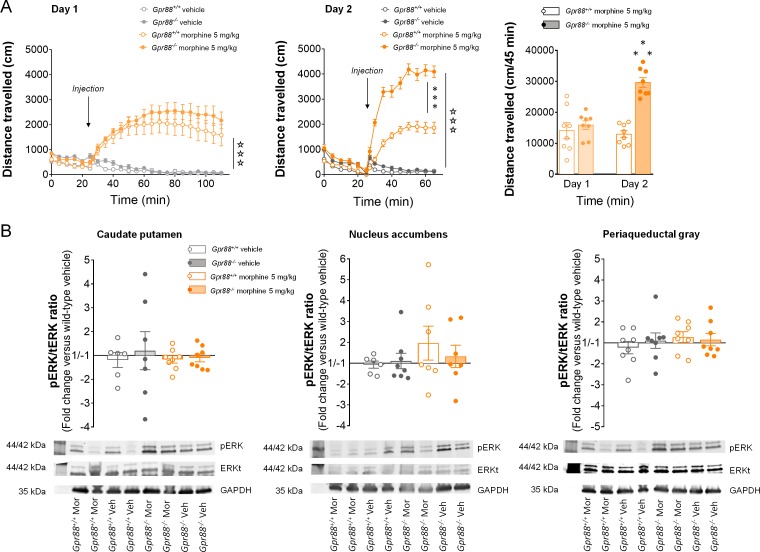
Increased morphine-induced locomotor sensitization in Gpr88 null mice was not associated with modified pERK/tERK ratio in three brain regions.(A) In a two-day locomotor sensitization paradigm (n = 8 mice per treatment and genotype), morphine (5 mg/kg) induced an increase in locomotor activity (Day 1; Genotype: F1,28=0.83, p=0.3690; Treatment: F1,28=63.4, p=0.0000; Time: F17,176=11.1, p=0.0000) that sensitized after a second administration (Day 2) in Gpr88-/- but not Gpr88+/+ mice (right panel; Genotype: F1,28=78.2, p=0.0000; Treatment: F1,28=365.5, p=0.0000; Genotype x Treatment: F1,28=58.9, p=0.0000; Time: F8,224=76.8, p=0.0000; Time x Genotype: F8,224=7.0, p=0.0000; Time x Treatment: F8,224=139.9, p=0.0000; Time x Genotype x Treatment: F8,224=13.13, p=0.0000). Data are presented as mean ± SEM. Open stars: Time x Treatment interaction, asterisks: Genotype x Treatment (three-way ANOVA with one repeated measure – time bin), three symbols: p<0.001. (B) The mice were sacrificed 60 min after the second morphine challenge for western blot analysis. Upper panels: in contrast with in vitro results, no difference was observed in the pERK/tERK ratio between Gpr88-/- and Gpr88+/+ animals in either striatal regions (caudate putamen: Genotype: F1,25=0.10, p=0.7516; Treatment: F1,25=0.28, p=0.5978; nucleus accumbens: Genotype: F1,24=1.4, p=0.2556; Treatment: F1,24=0.18, p=0.6719), where µOR activation induces morphine sensitization, or in a µOR-expressing region not involved in the sensitization process, the periaqueductal gray (Genotype: F1,28=0.80, p=0.3776; Treatment: F1,28=011, p=0.7378). Lower panels: representative western blotting images. Levels of phosphorylated-ERK (pERK) and total-ERK (tERK) were normalized to the loading control protein glyceraldehyde 3-phosphate dehydrogenase (GAPDH). Data are presented as individual values and mean ± SEM of n = 3–4 independent experiments. Two brain punches were lost for striatal regions in the Gpr88+/+ vehicle group.